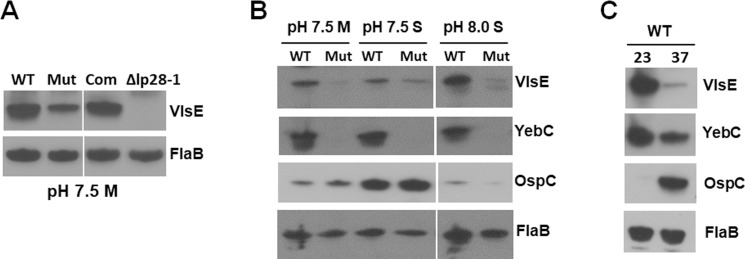
Immunoblot analysis of VlsE and YebC protein levels.Wild-type B. burgdorferi strain 5A4NP1 (WT), the yebC mutant (Mut), the complemented strain (Com), or a B31 clone lacking the entire plasmid lp28-1 (Δlp28-1) were cultured in BSK-II medium at pH 7.5, 37°C, and harvested at the mid-log phase (M) (A), or cultured under various pH conditions (pH 7.5, or 8.0) at 37°C, and harvested at either mid-log (M) or stationary phase (S) (B), or cultured at 23°C (pH 7.5) and harvested at stationary phase (C). Cell lysates were probed with antibodies against VlsE, YebC, OspC, or FlaB (loading control).